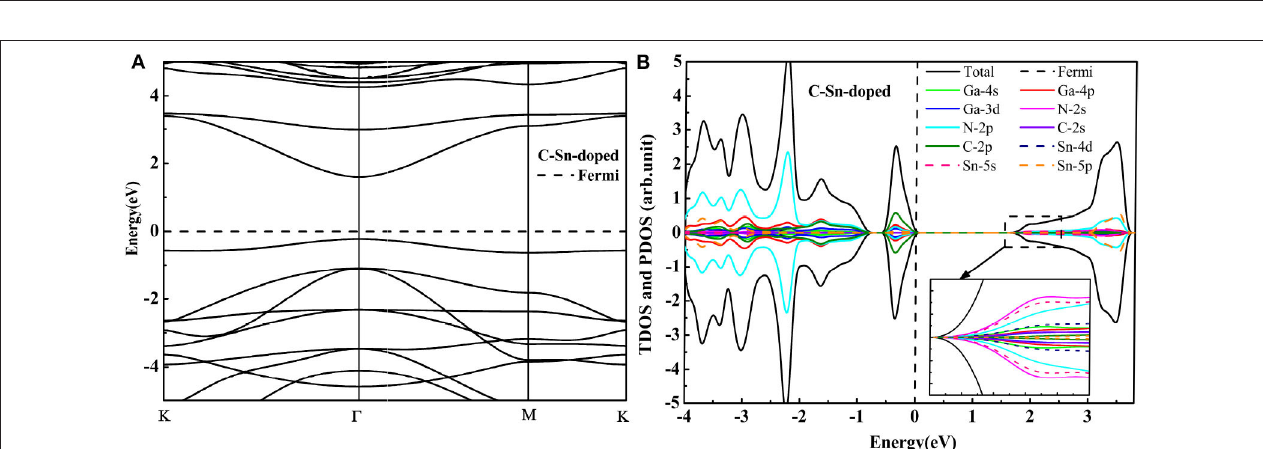
FIGURE 3 | The HSE06 calculated band structure (A) and DOS (B) of the C-Ge codoped GaN nanosheet.